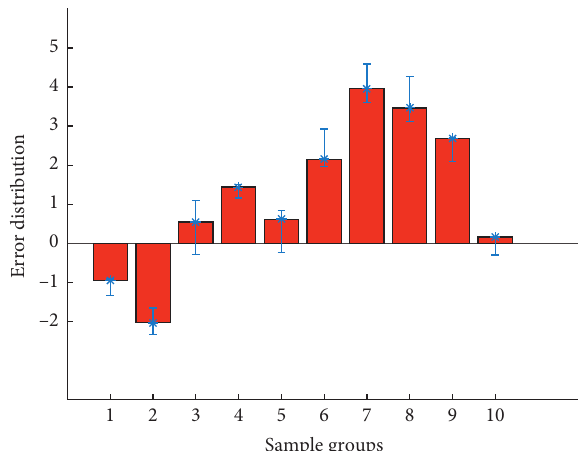
Figure 8: 3D coordinate error distribution of multivisual ani- mation